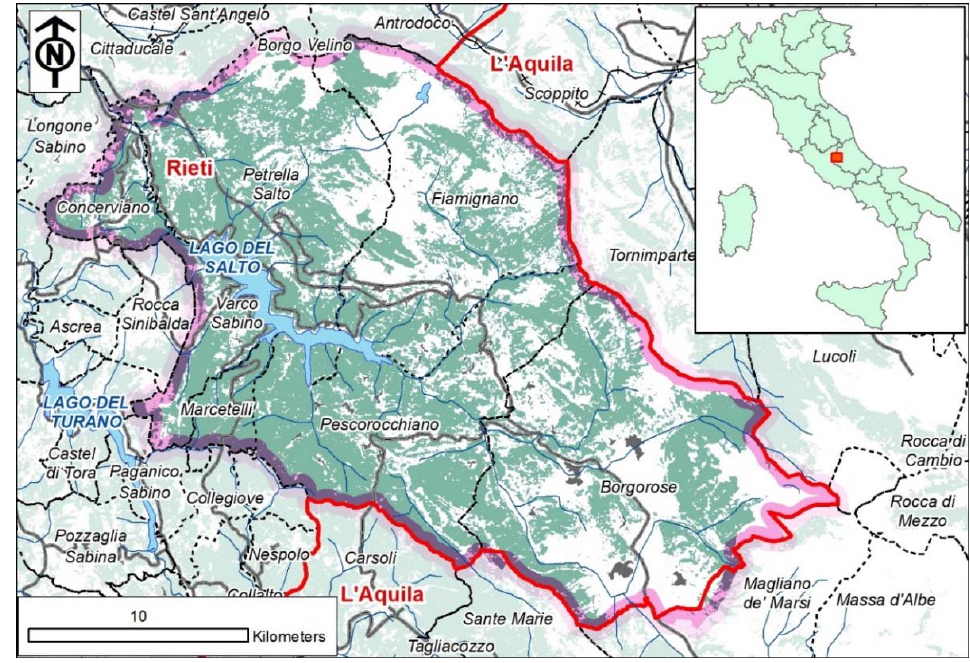
Figure 1. Map of the study area belonging to the “Salto Cicolano” mountain community (Rieti Province, Lazio Region). Regional border in red. Forest cover in green.